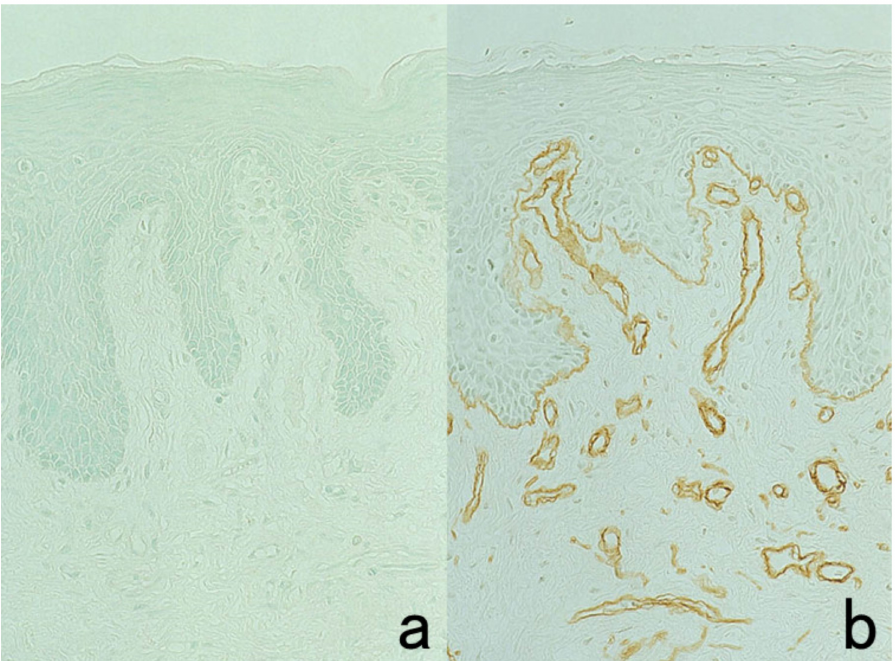
Figure 30. Effect of trypsin digestion in immunostaining for type 4 collagen in the normal skin. ( a ): Immunostaining without treatment and ( b ): after 0.1% trypsin digestion at 37 ◦ C for 30 min. Type 4 collagen immunoreactivity in the basement membrane is clearly visualized after trypsin digestion. The nuclei are counterstained with methyl